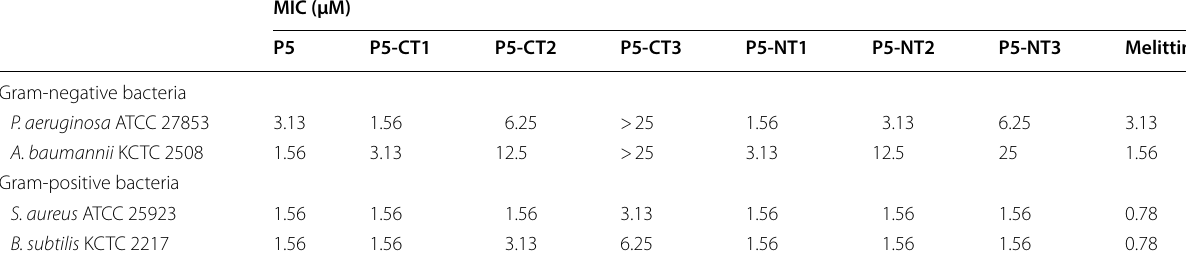
CT C-terminus, NT